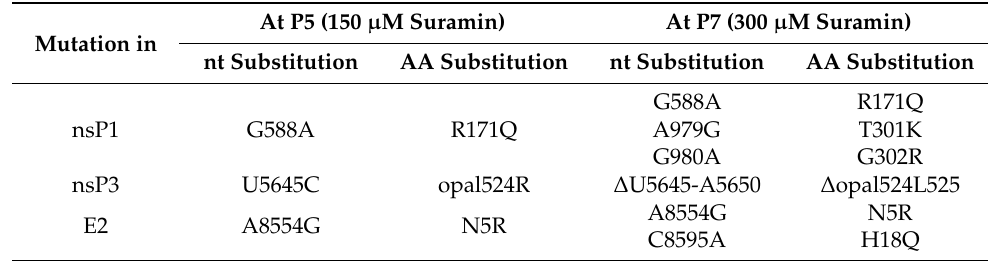
Table 1. Mutations in CHIKV resulting from serial passaging in the presence of increasing (suboptimal) concentrations of